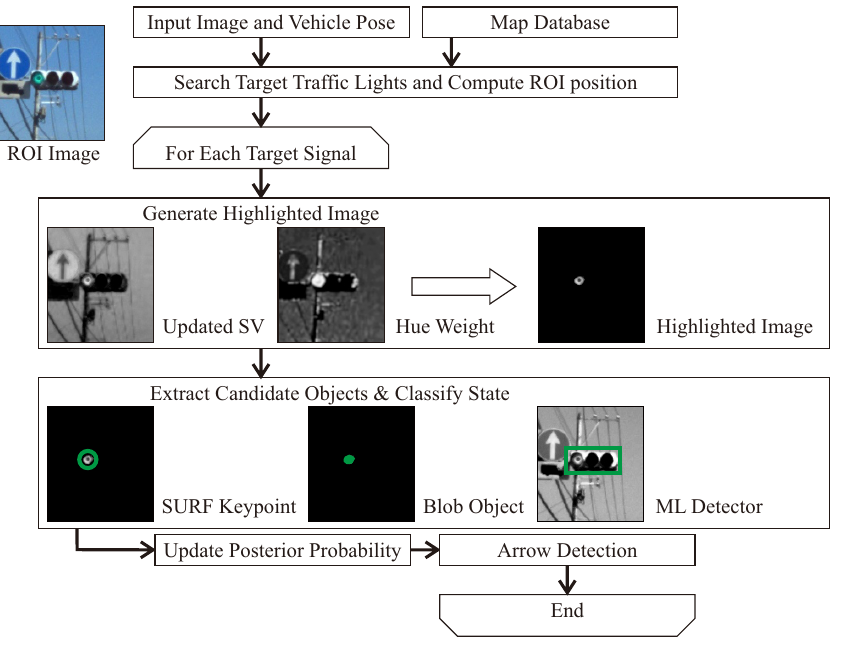
Figure 3. Flowchart of the proposed method.